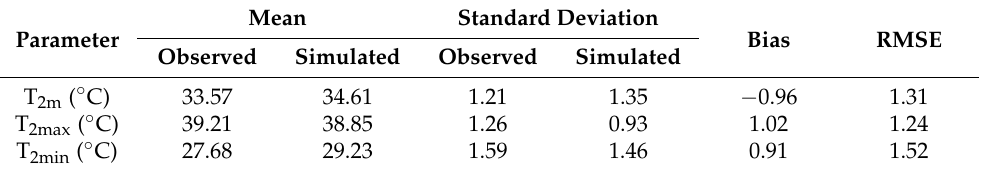
Table 4. Observation and simulation of mean temperature at 2 m height in the innermost layer.